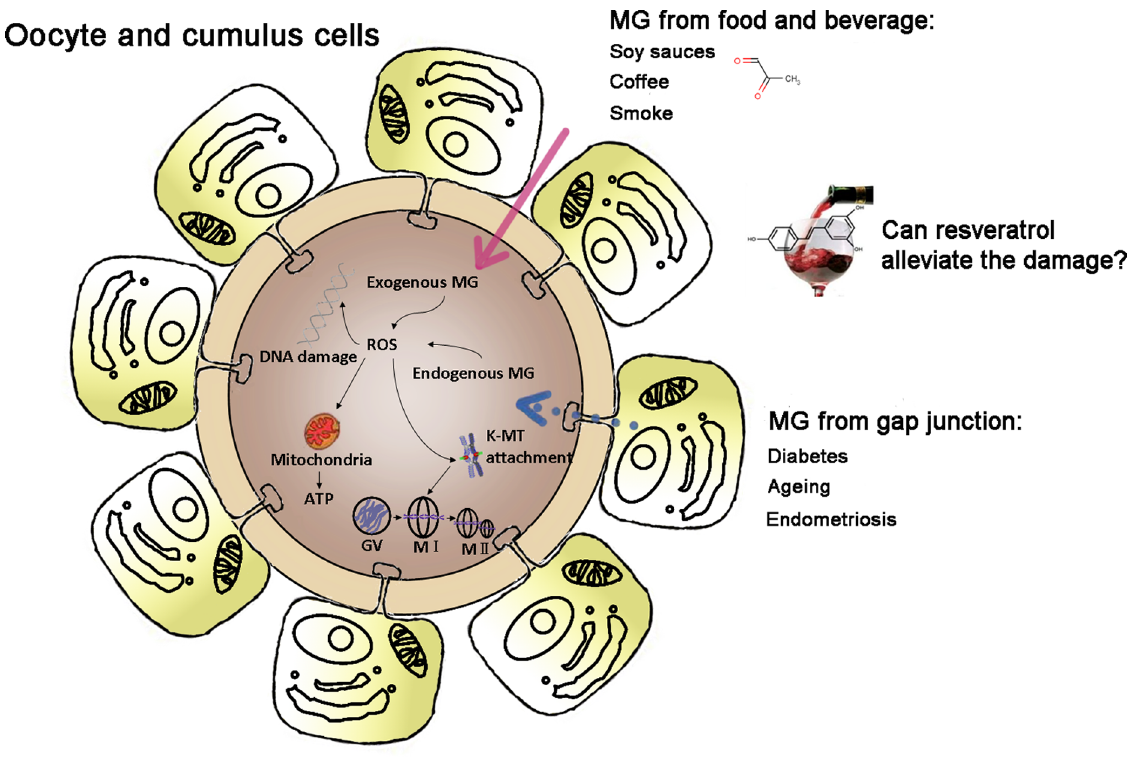
Figure 8. A schematic diagram showing that resveratrol could alleviate MG-induced cytotoxicity in oocytes.